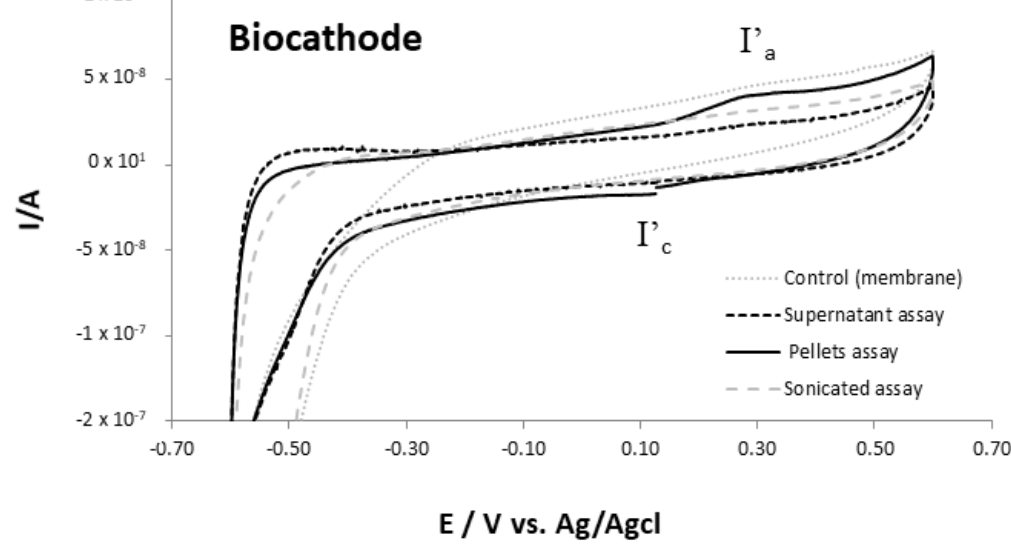
Figure 2. Ex situ cyclic voltametric features of the cathodic chamber wastewater sample with bacteria cells in suspension; potential window between − 0.6 and +0.6 V; scan rate 20 × 10 − 3 V s − 1 ; full scale at SI (Figure S3).